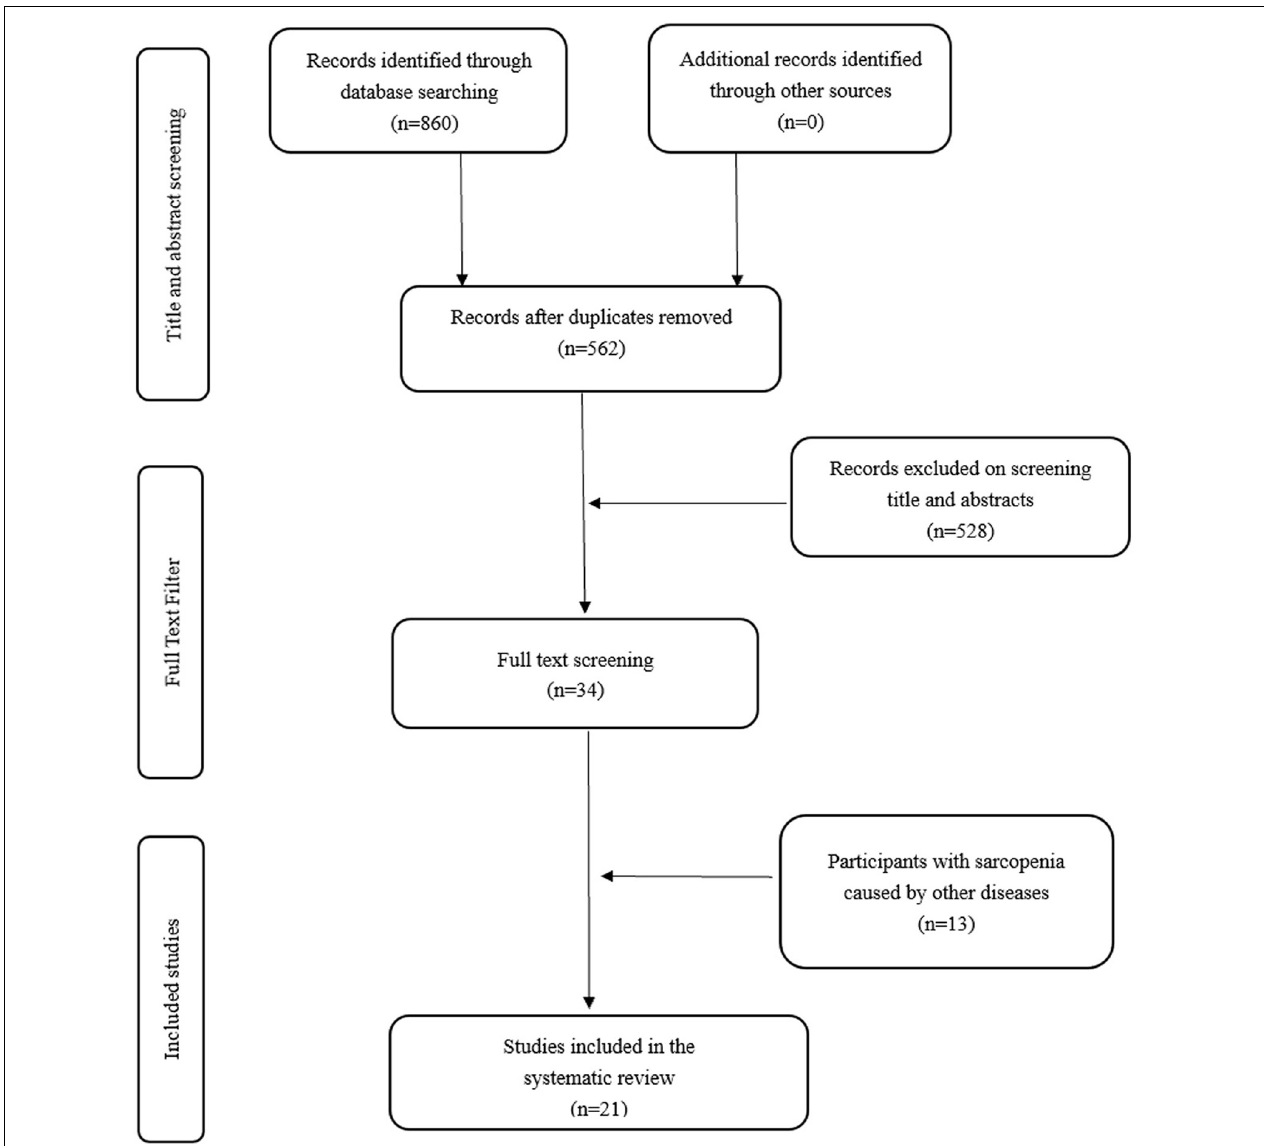
FIGURE 1 | Flow diagram of the selection criteria for the